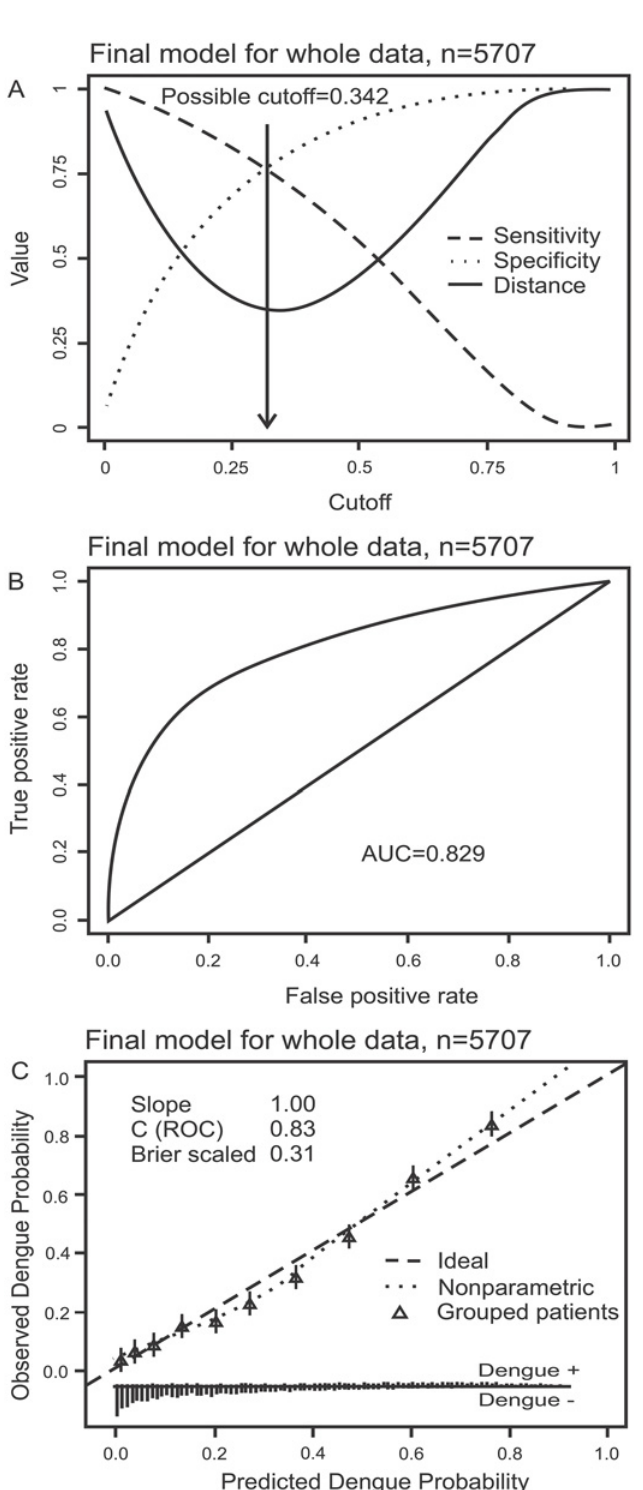
Fig 1. Performance of the Early Dengue Classifier (EDC) in all subjects. Figure A displays possible sensitivity/specificity trade-offs for different cut-off values and the distance from the corresponding points on the ROC curve to the upper left corner (perfect model). Figure B displays the receiver operating characteristic (ROC) curve. Figure C is a calibration plot. It displays a scatterplot-smoother of predicted versus